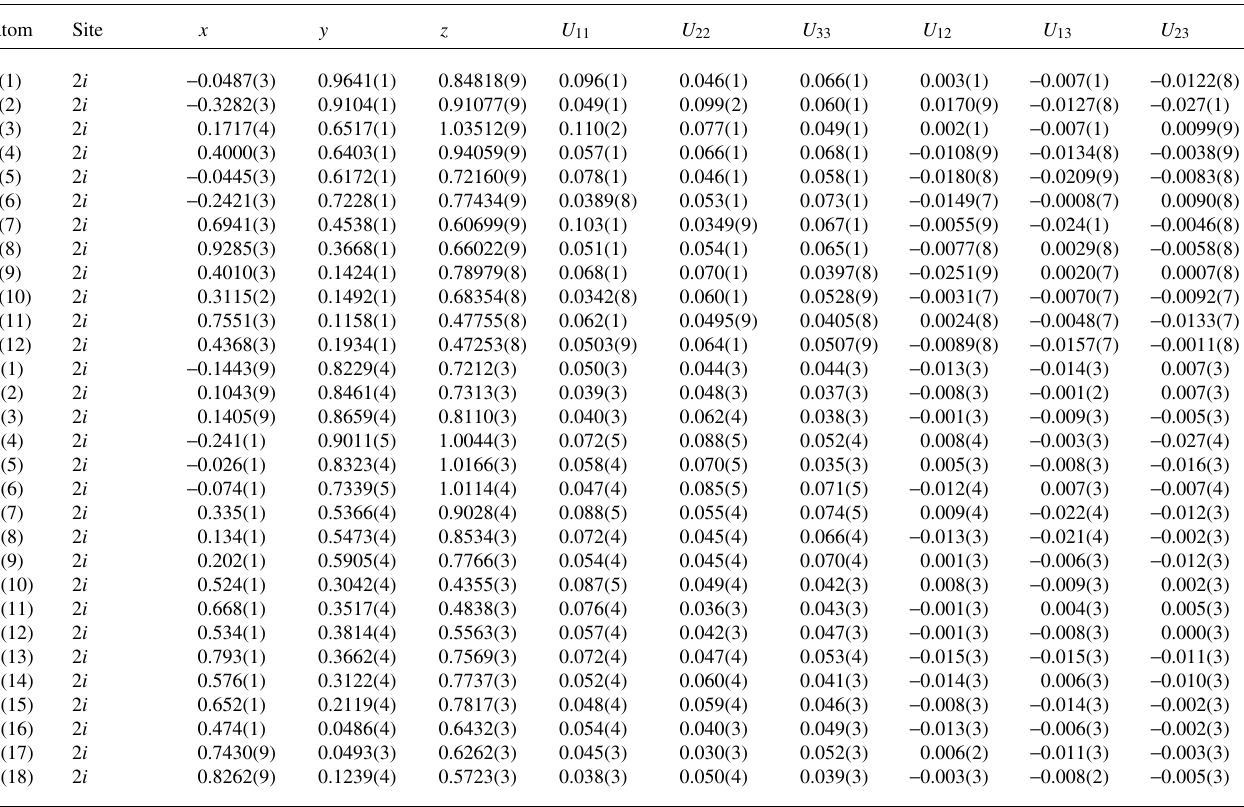
Table 3. Atomic coordinates and displacement parameters (in Å 2 )